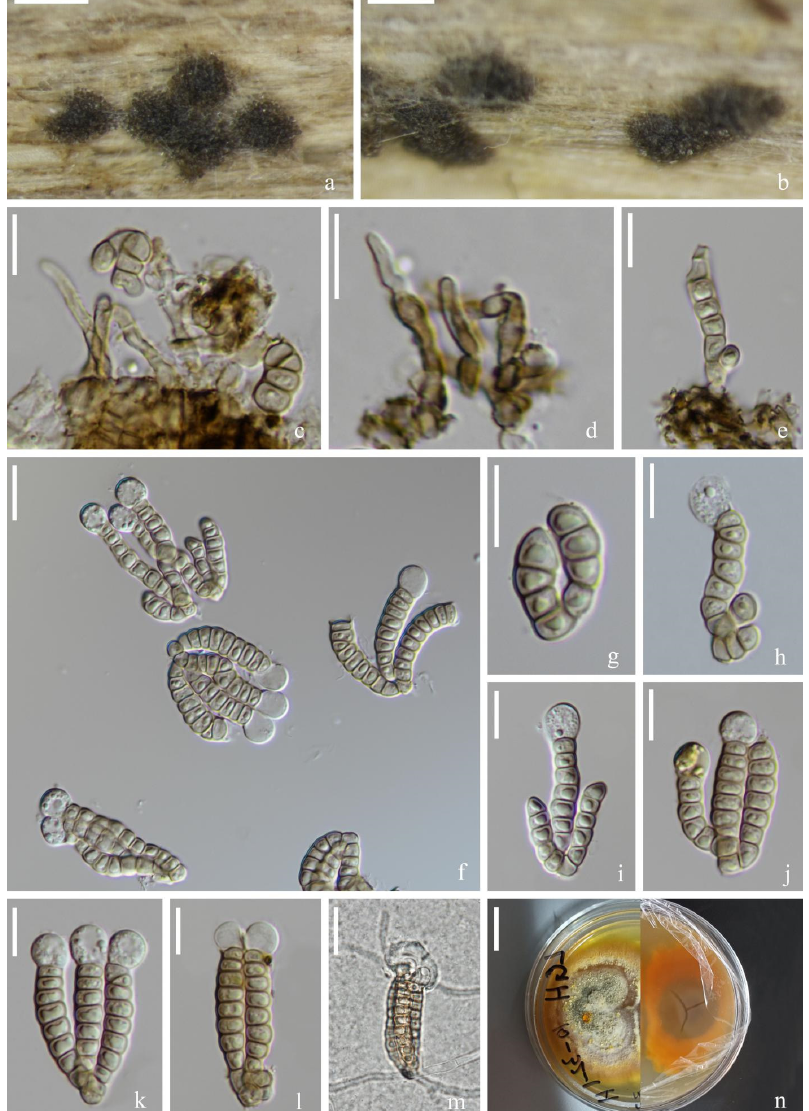
Figure 11. Vikalpa sphaerica (KUN-HKAS 115805, holotype). ( a , b ) Colonies on the substratum. ( c , d ) Conidiophores and conidiogenous cells. ( e ) Conidia. ( f – l ) Conidia with appendages. ( m ) Germinating conidium. ( n ) Culture colonies on PDA, reverse (left) and obverse (right). Scale bars: ( a , b ) 200 μ m, ( c – m ) 10 μ m and ( n ) 1 cm.